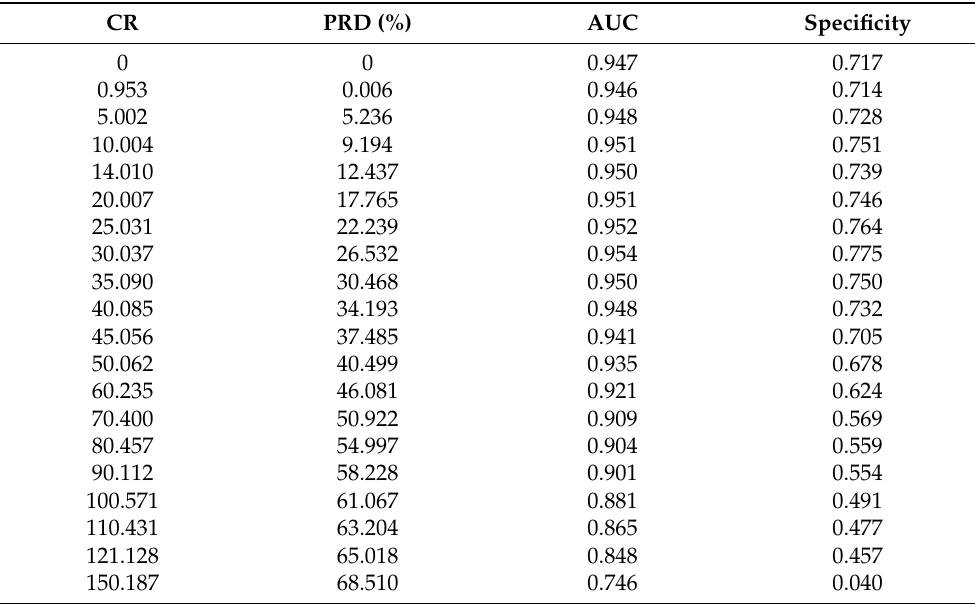
Table 1. ROC parameters for different compression rates for a fixed Sensitivity equal to